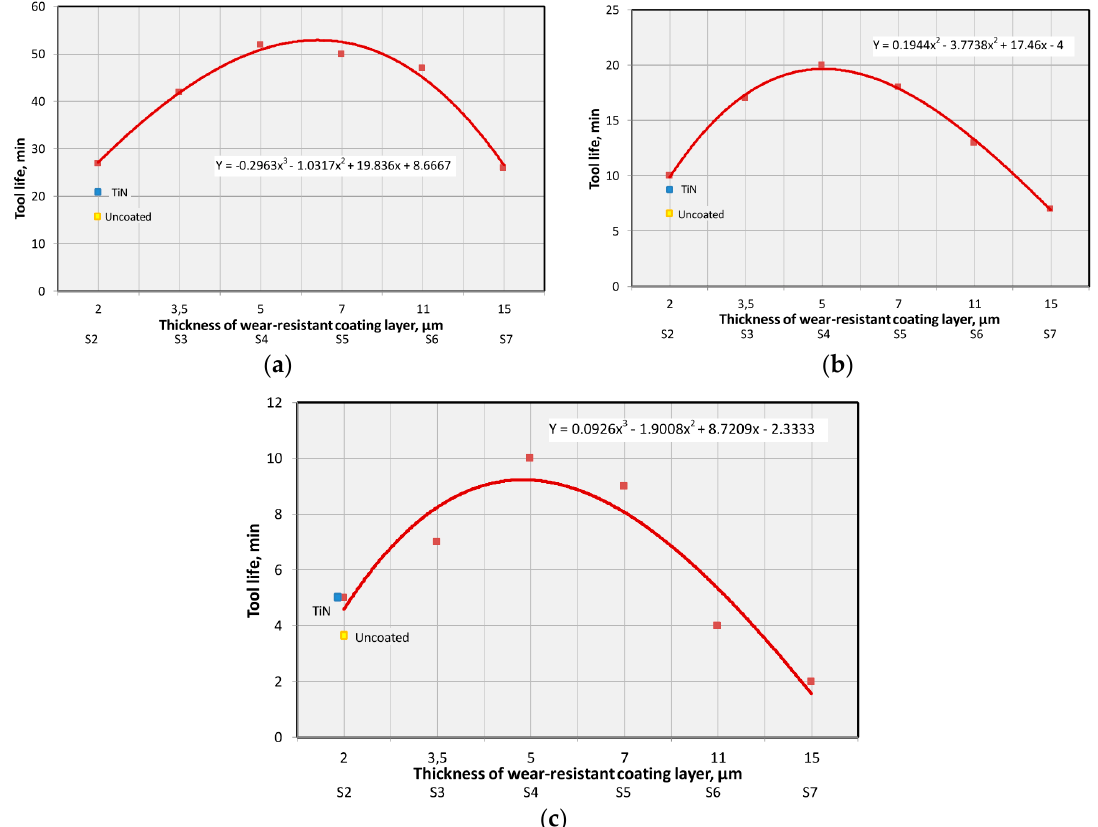
Figure 15. Relationship between the tool life of a carbide tool and the thickness of a wear-resistant coating layer during longitudinal turning of steel C45 ( f = 0.25 mm/rev, a p = 1 mm, and ( a ) v c = 250 m/min, ( b ) v c = 300 m/min ( c ), v c = 350 m/min).